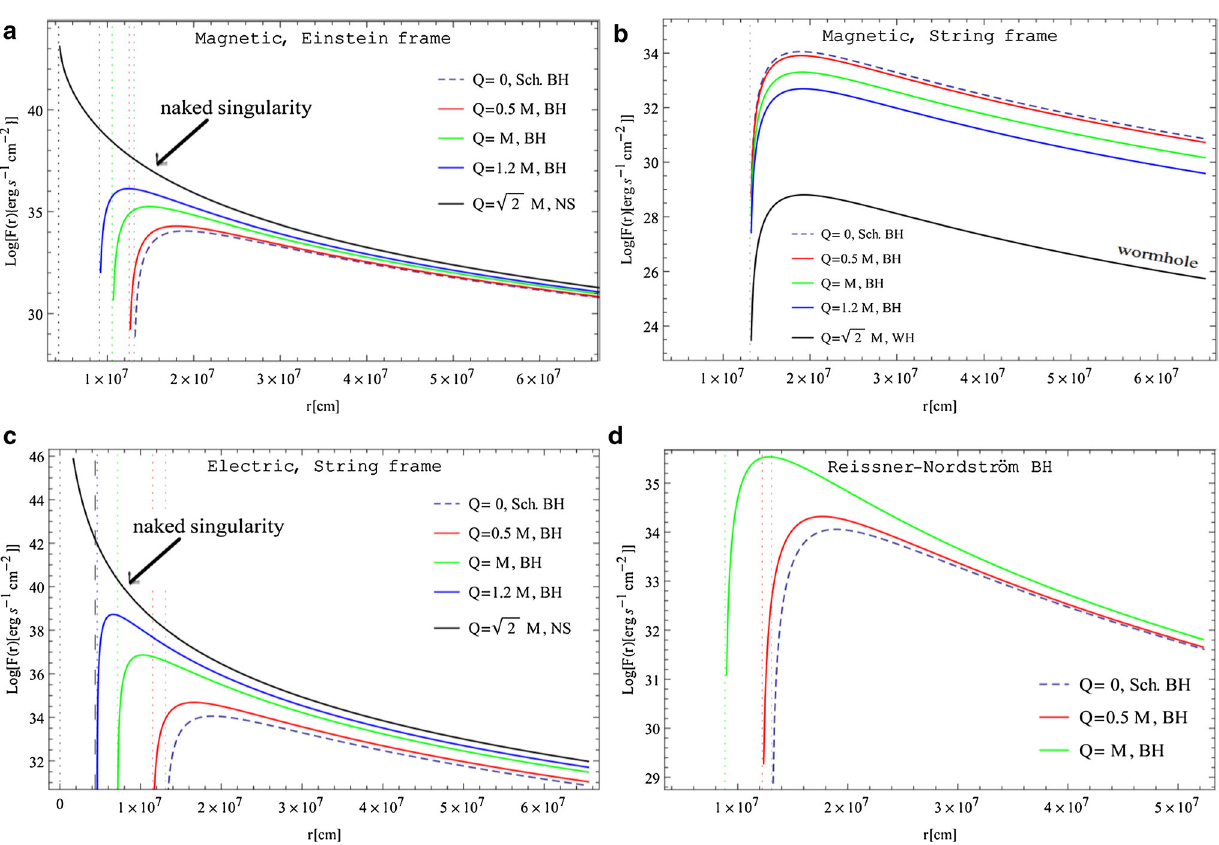
Fig. 4 The time averaged radiation flux F ( r ) as a function of the radial coordinate r (incm)radiatedbythediskaroundaGMGHSBHinEF( a ), magneticallychargedintheSF( b ),electricallychargedintheSF( c )and Reissner–Nordström BH ( d ) plotted for different values of Q . We see